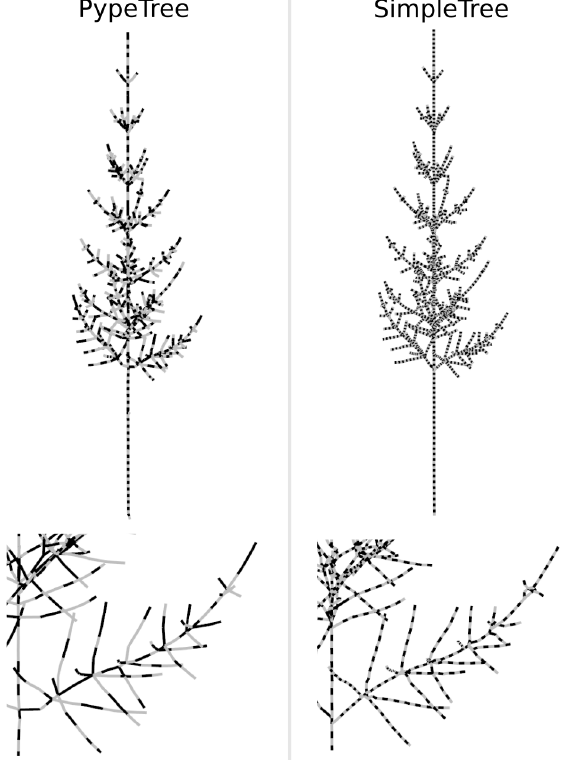
Figure 7. Comparison between the skeletons of a 10-year-old simulated tree extracted using the PypeTree ( left ) and SimpleTree ( right ) models. The whole tree ( top ) and details of a branch ( bottom ) with the segments shown in black and